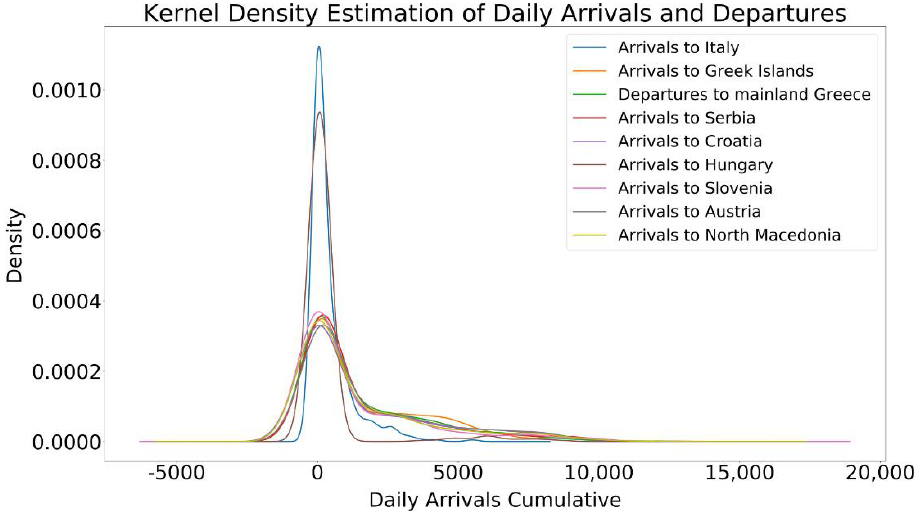
Figure 4. KDE plot showing extreme right skewing denoting the sporadicity of influx events with high magnitude.